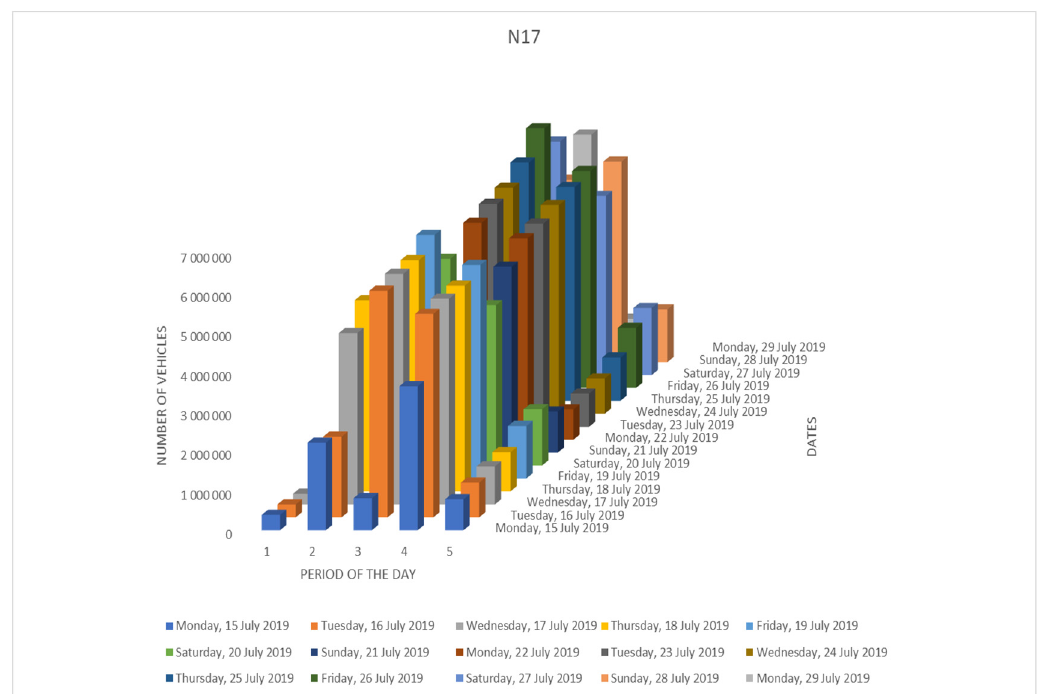
Figure A4. N14 Freeway